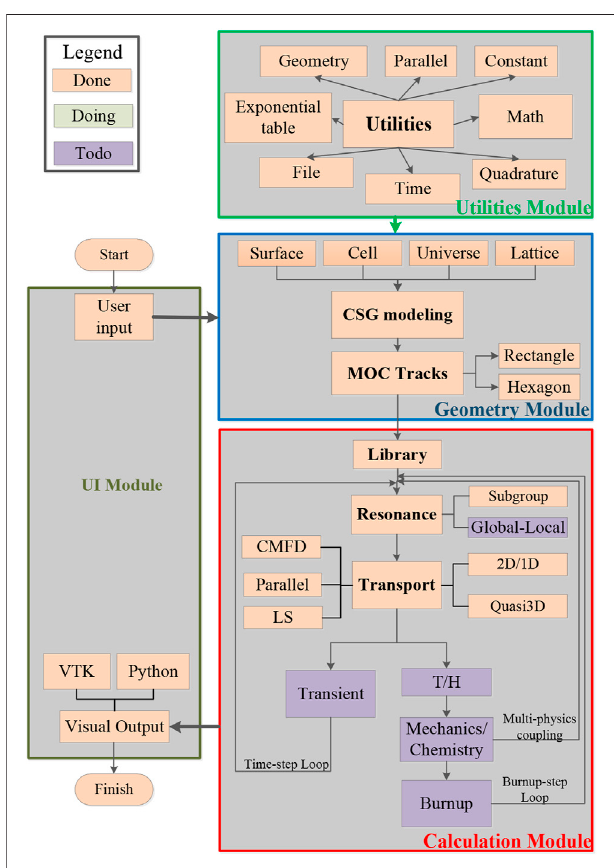
FIGURE 1 | The framework and modules of Simulation-based High- fi delity Advanced Reactor physics Kit (SHARK).